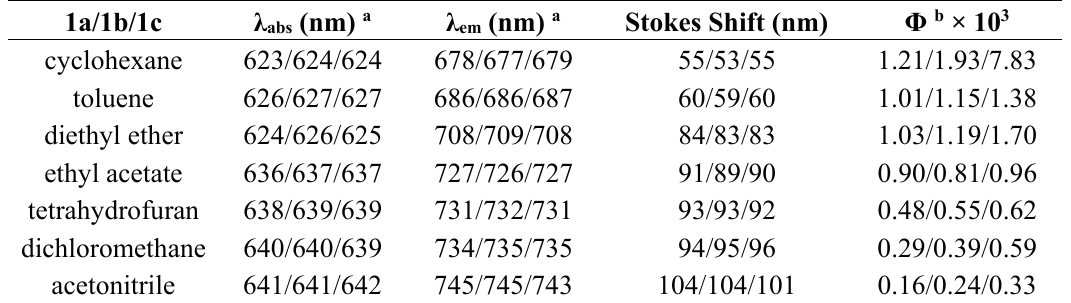
Table 2. Summary of optical absorption and emission properties of 1a – 1c in various solvents.